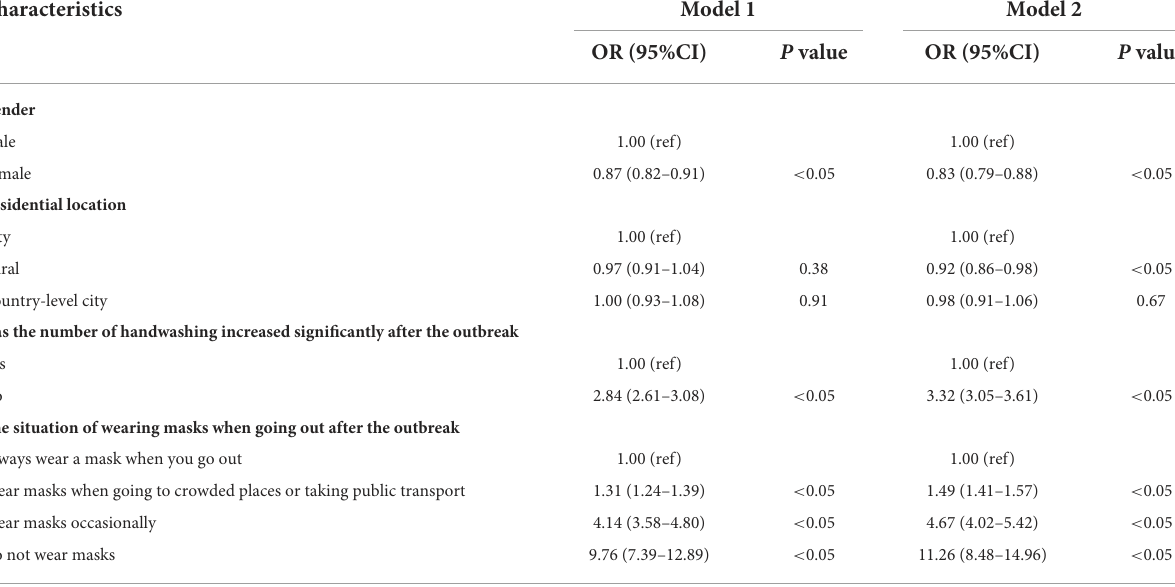
TABLE 3 Independent association of characteristics of study participants and depression during the COVID-19 epidemic in Henan province.